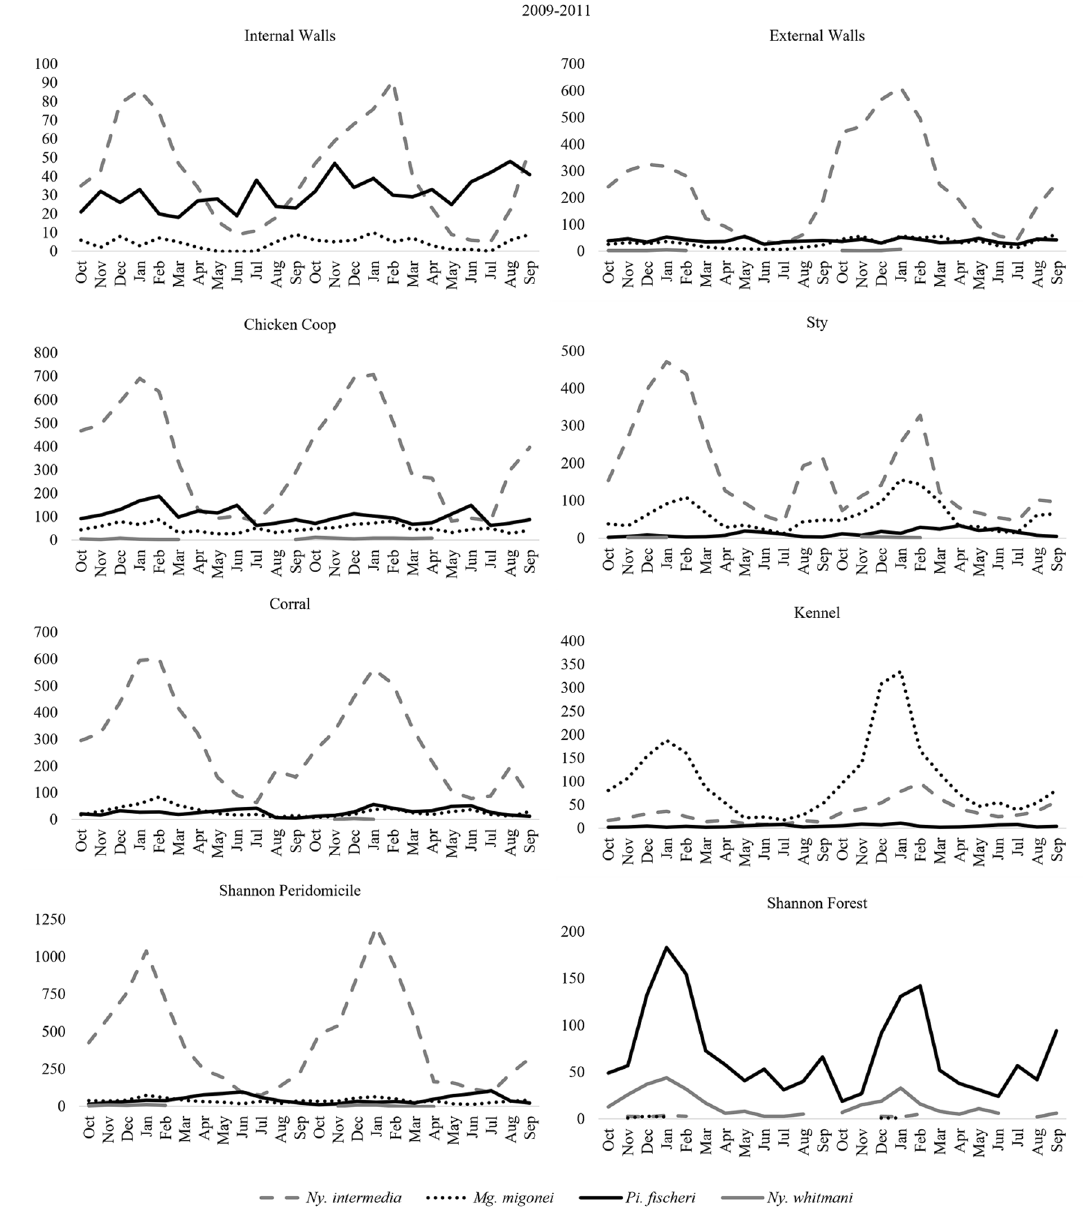
Figure 4. Monthly Frequency of Sand flies: Nyssomyia intermedia , Migonemyia migonei , Pintomyia fischeri and Nyssomyia whitmani , captured in the internal and external walls of the house, in the annex of domestic animals (chicken coop, sty, corral and kennel) and in the Shannon light trap (peridomicile and in the forest), from October 2009 to September 2011, in the neighborhoods of São Gonçalo, Municipality of Paraty, State of Rio de Janeiro,